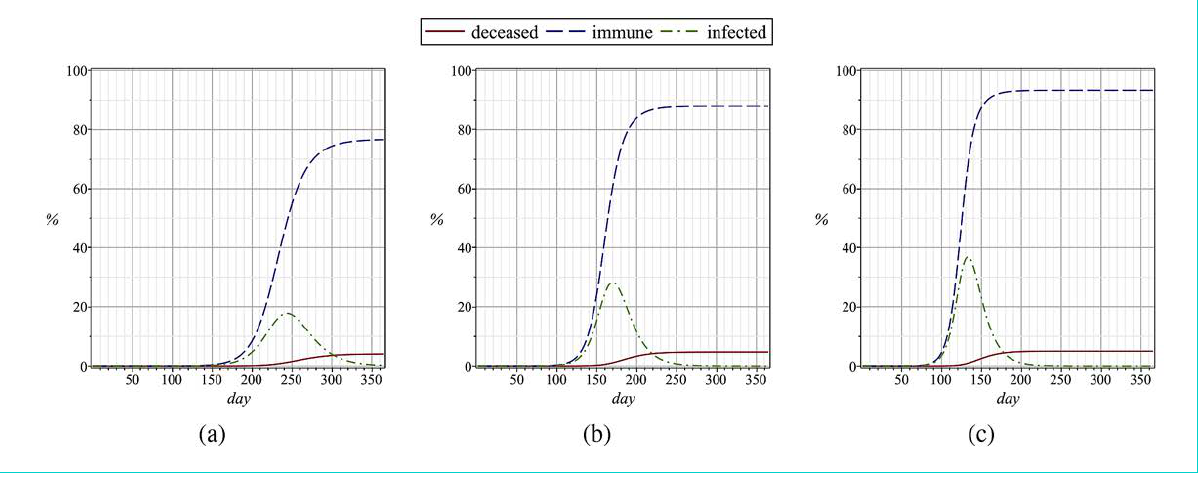
Figure 2: Predictions for a period of 1 year. with mune ( ), dash-dotted lines the infected ( in % of the initial population size and are plotted over number of days. 𝑠𝑠0 𝑛𝑛 − 𝑛𝑛 𝑠𝑠